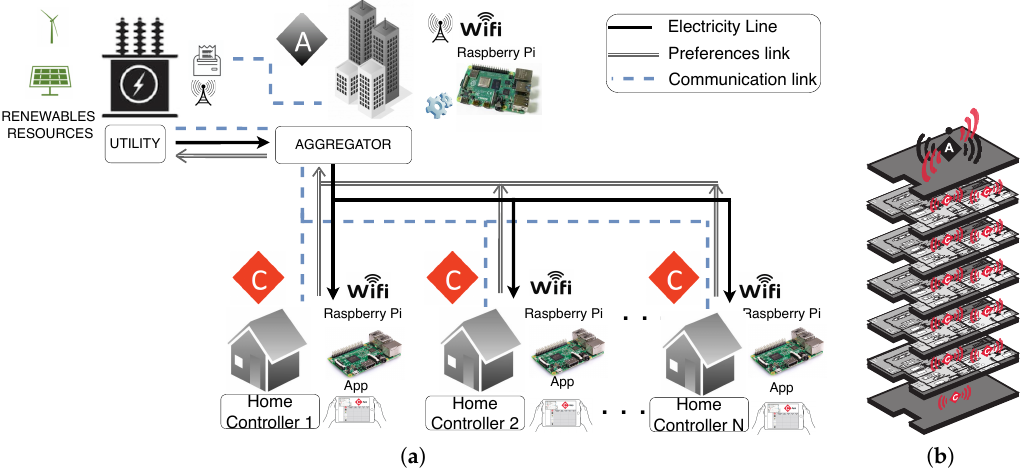
Figure 2. ( a ) Cooperative demand response framework for a smart community targeting renewables; ( b ) The residential building of a series of households containing a home controller device (C-diamond) that communicates via WiFi with the common aggregator (A-diamond).